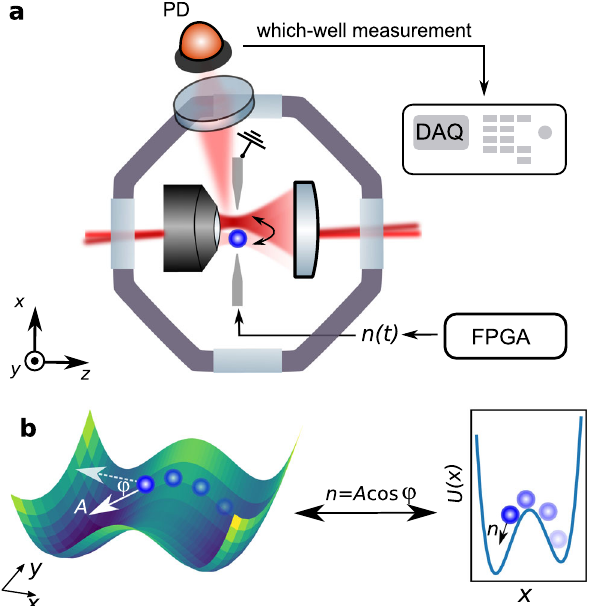
Fig. 1 Model under study and experimental setup. a Experimental